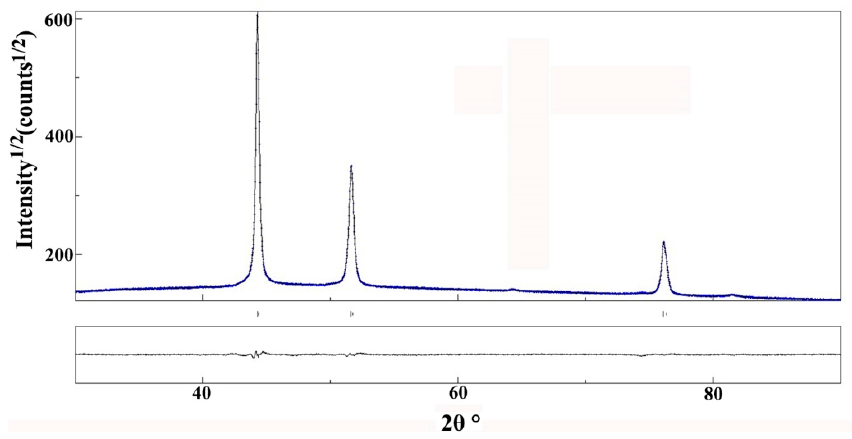
Figure 7. Rietveld plot of the Ni–Cr–graphene coatings of 8 g/L graphene (sigma = 1.69, R w = 1.13%, R exp = 0.67%).